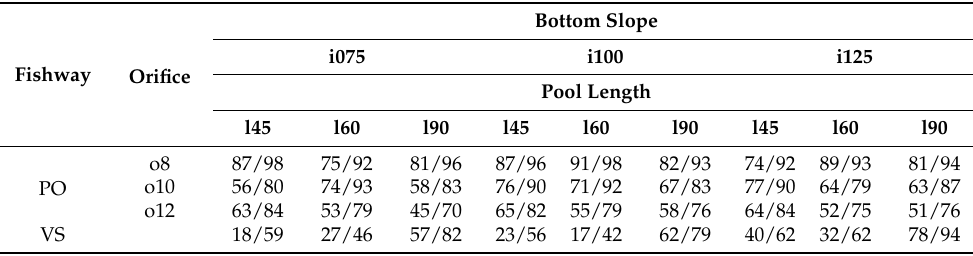
Table 1. Fraction (%) of the Reynold’s shear stress values below disorientation/injury boundary in the main flow jet